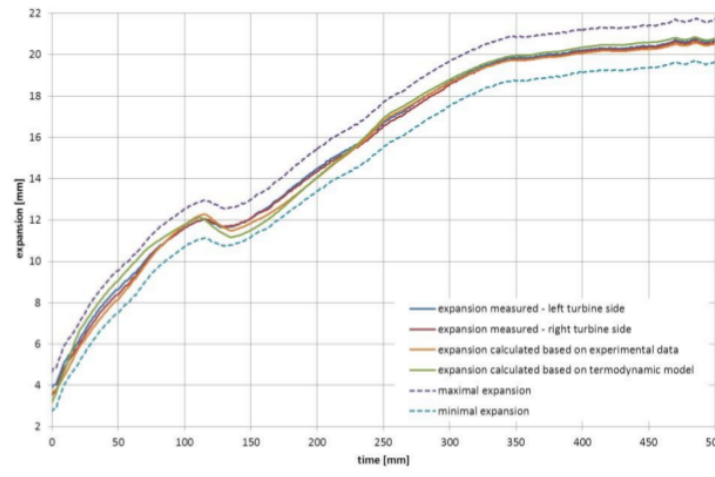
Figure 7: HP rotor axial expansion during cold startup: calculations and